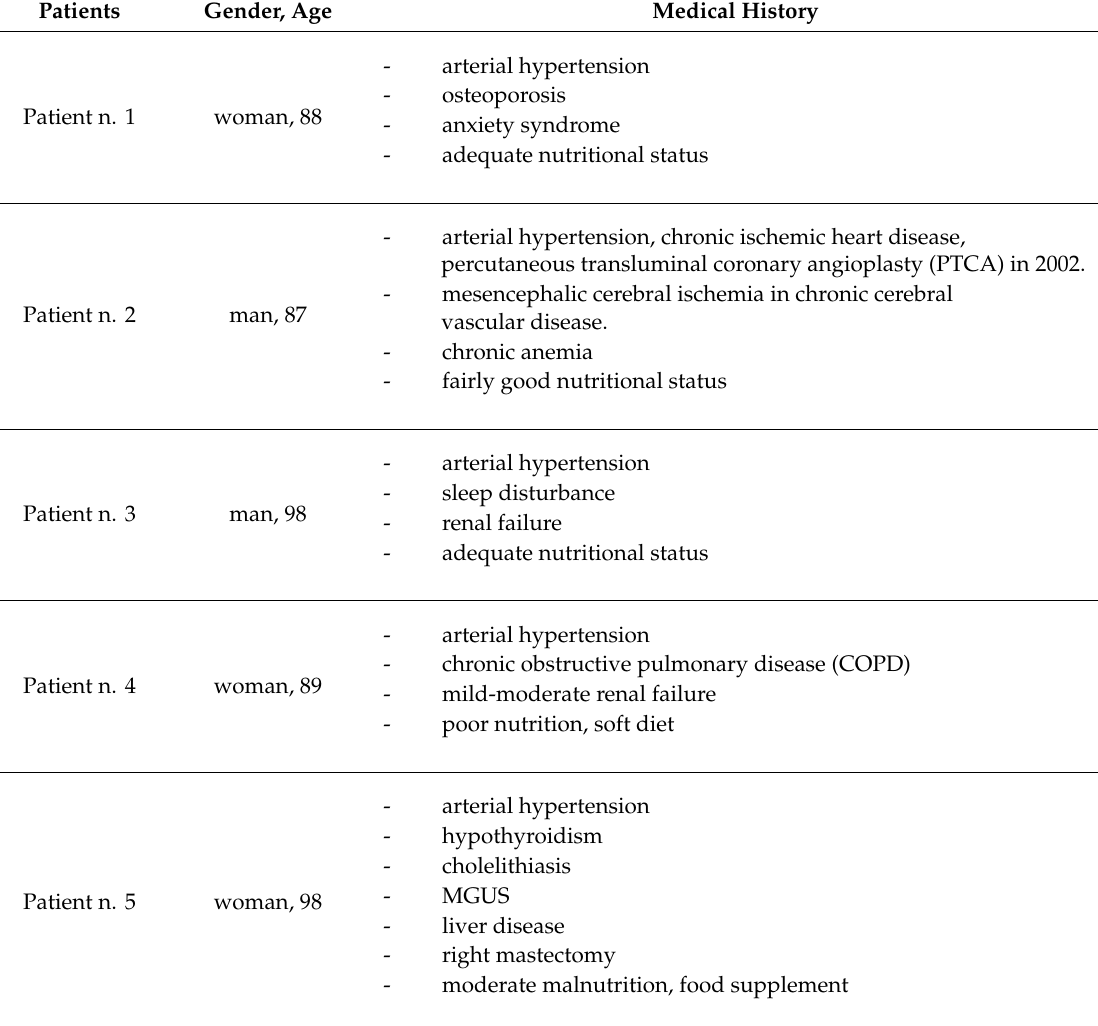
Table 1. Gender / Age, medical history of included